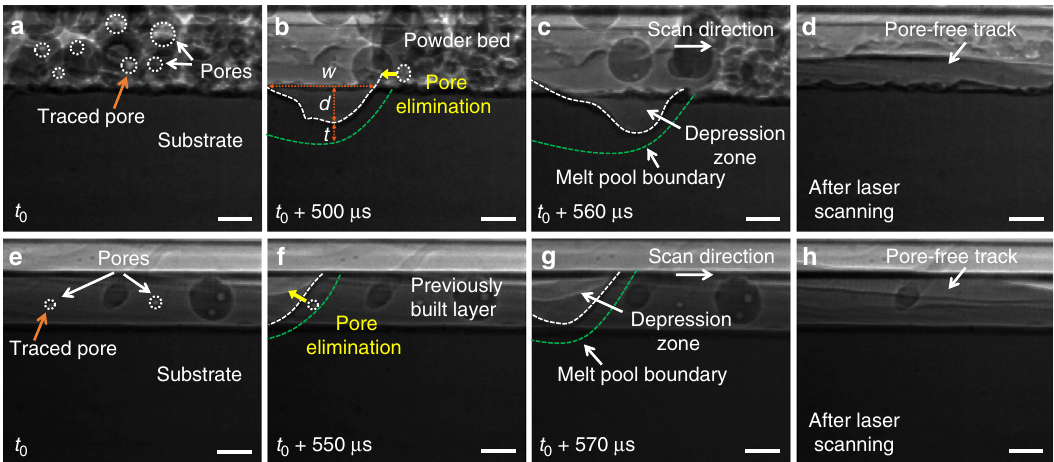
Fig. 7 Eliminating pores using thermocapillary force. a – d Dynamic X-ray images showing elimination of pores in feedstock powders. The thickness of powder layer is 100 μ m. In b w and d indicate the depression zone width and depth, respectively, and t represents the thickness of the liquid layer around the depression zone. e – h Dynamic X-ray images showing elimination of pores in the previously built layer. Traced pores are indicated by orange arrows. Pore moving trajectories are indicated by yellow arrows. The melt pool and depression zone boundaries are outlined by green and white dashed-lines, respectively. The powder and substrate are Ti6Al4V. The laser beam diameter ( D 4 σ ), laser power, and scan speed are 75 μ m, 210 W, and 0.6 m s − 1 , respectively. All scale bars are 50 μ m